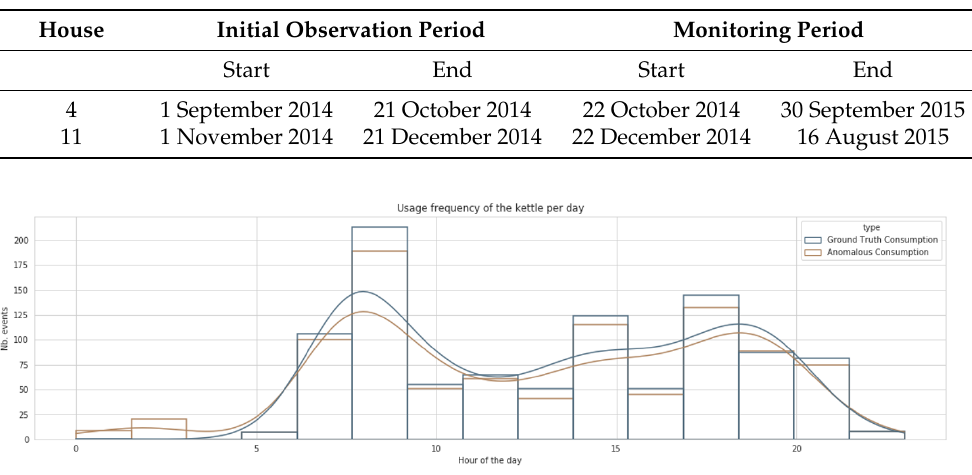
Table 5. The periods of time used during phase 02.